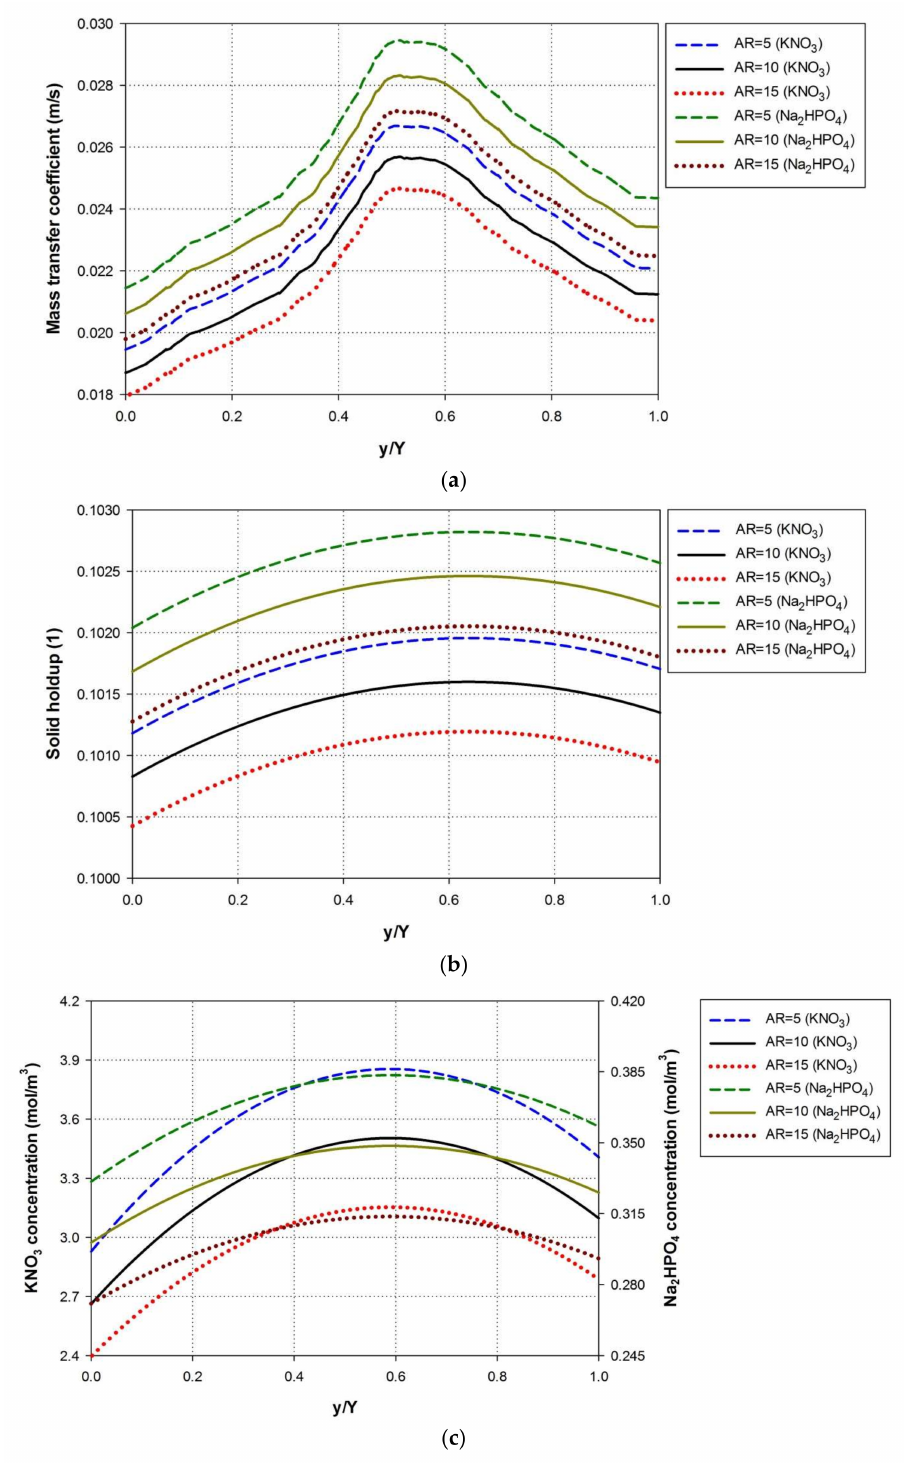
Figure 6. Effects of AR s on ( a ) mass transfer coefficient; ( b ) solid holdup; and ( c ) nutrient concentrations at water depth = 0.2 m and paddle wheel speed =